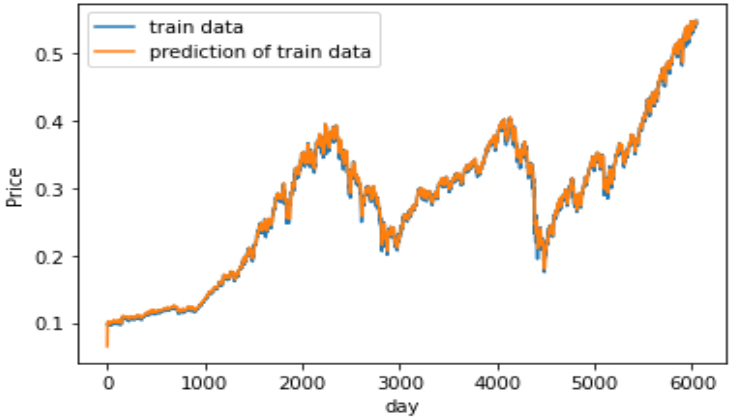
Figure 6. GRU predictions using the train